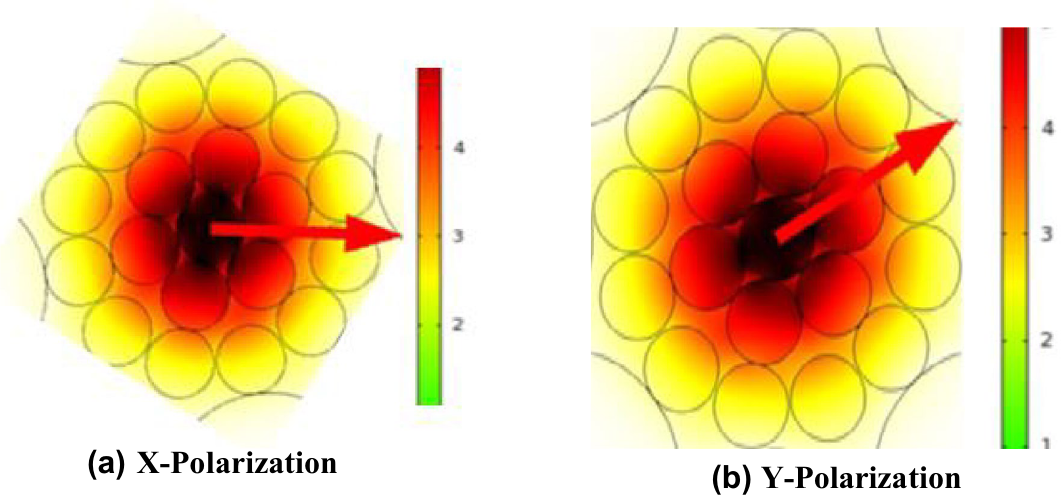
Fig. 2 Electric Mode field distributions for ( a ) x-polarization and ( b ) y-polarization at the controlling region of 1 THz